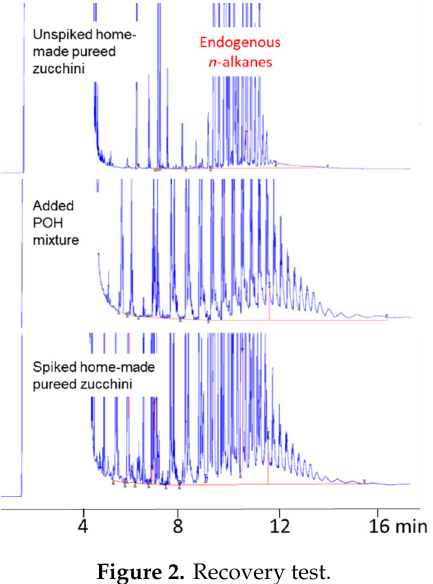
Figure 2. Recovery test.